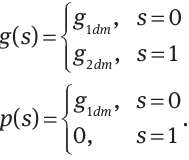
equal, but they are different in the latter. The functioning of the two circuits is as follows.